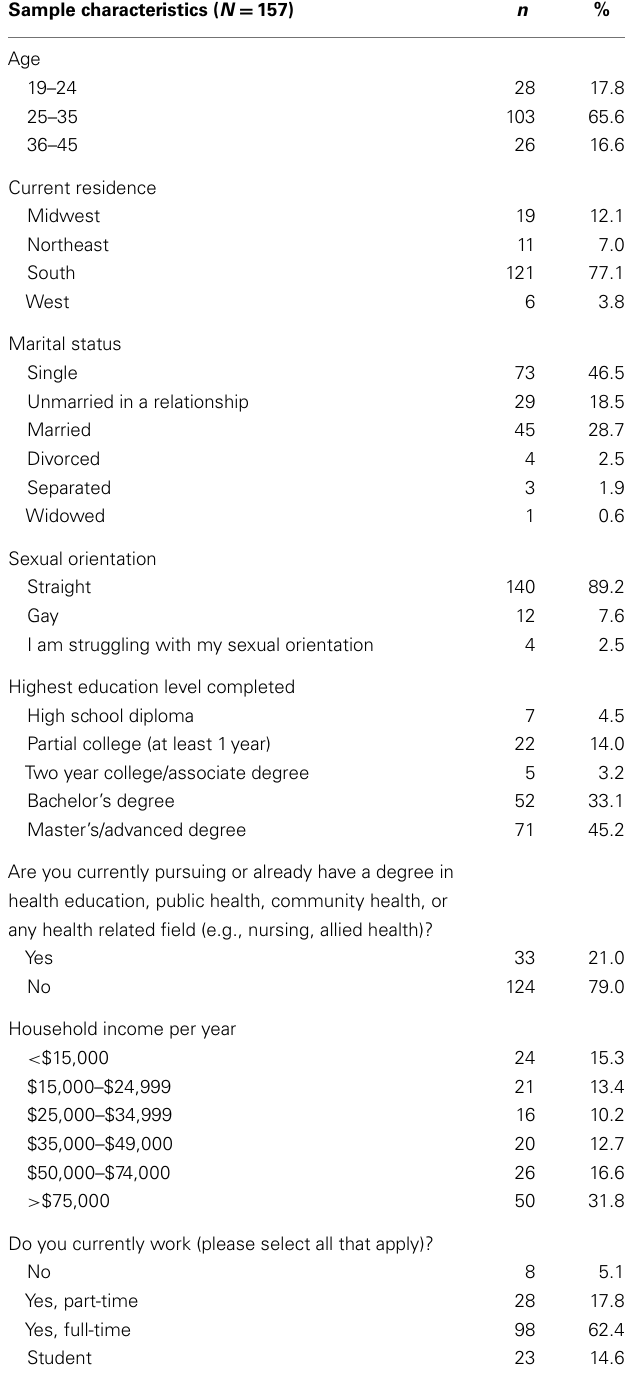
Table 2 | Participant demographic characteristics a